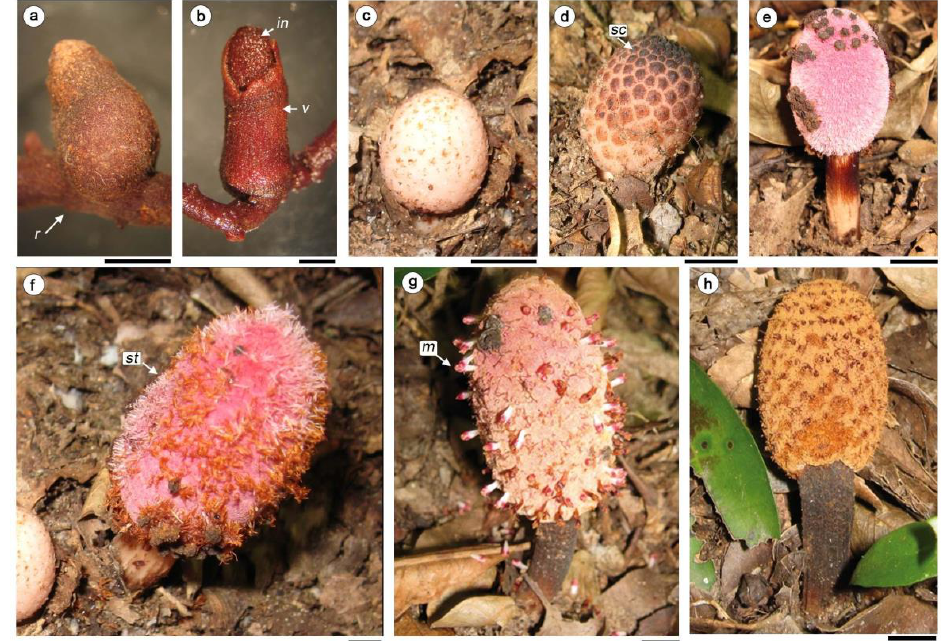
Figure 1. Inflorescence development of H. cayennensis , ( a , b ) material in FAA, ( f – h ) in the field. ( a , b ) stage I. ( a ) Inflorescence covered by volva. ( b ) Volva rupture. ( c , d ) Stage II, flowers covered by scales. ( e , f ). Stage II, female phase, some scales remain at apex in photo ( e ). ( f ) Stage II, stigmata are exposed over the filariae. ( g ) Stage III: male phase: male flower exposed. ( h ) Stage IV, fruiting phase. Abbreviations: m: male flowers; in: inflorescence, r: runner; sc: scale; st: stigmata; v: volva. Scale bar= ( a , b ) 0.2 mm, ( c – h ) 1